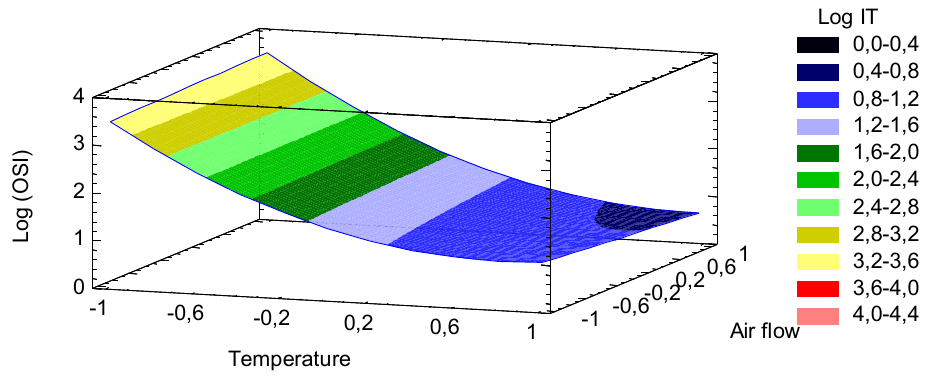
Figure 1. Curve showing predicted response surface of log oil stability index of CLA as a function of temperature (°C) and air flow